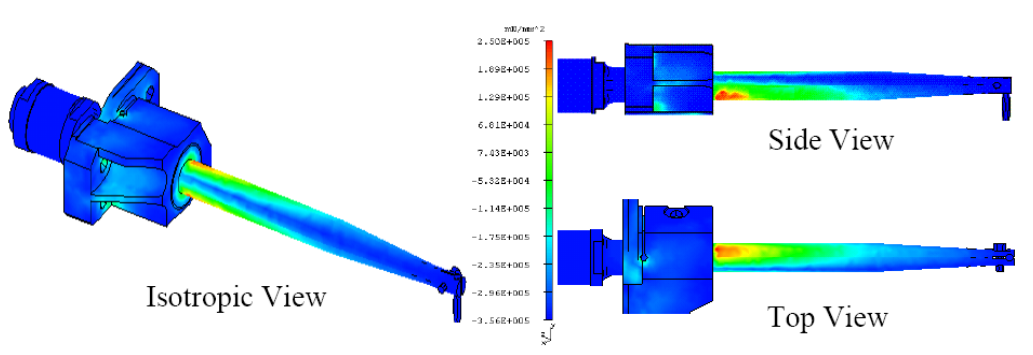
Figure 8. The stress distribution under mode 1 vibration predicted by FEM method.